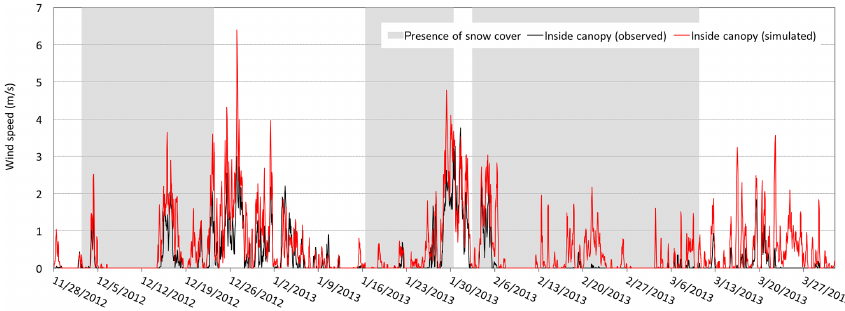
Figure 9. Simulated and observed wind speed inside the forest canopy for the winter period 2012/13 at site Vordersteinwald. The grey areas indicate periods with presence of a snow cover.